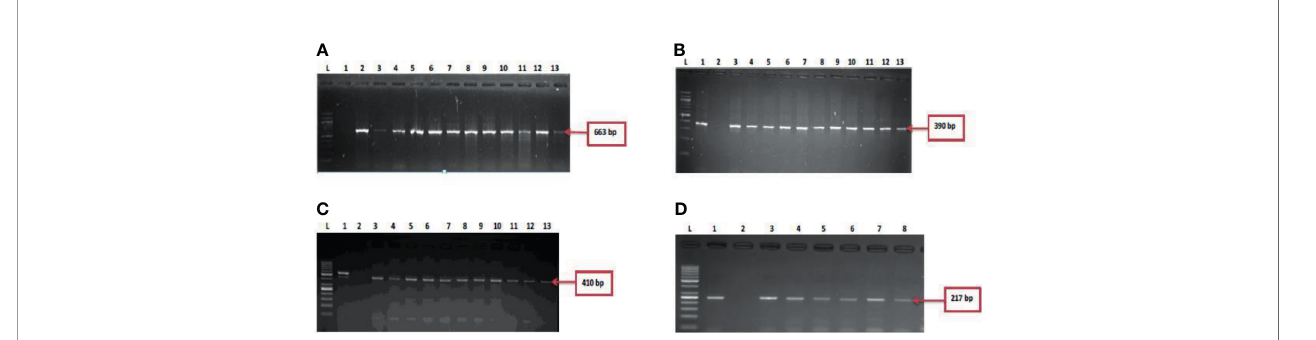
FIGURE 2 | (A) = gel electrophoresis showing the 16s rRNA gene among isolates belonging to the Vibrio genus. Lane L: Molecular DNA-marker (100 bp); Lane 1: Negative control (-ve); Lane 2-13: positive isolates of 16s rRNA gene (663 bp): (B) = Gel electrophoresis showing the vmh gene among isolates belonging to the V. mimicus . Lane L: Molecular DNA-Marker (100 bp), lane 1: positive control (DSM 19130), Lane 2: Negative control (-ve); Lane 3-13: positive isolates of vmh gene (663 bp); (C) = Gel electrophoresis showing the hsp60 gene among isolates belonging to the V. vulni fi cus. Lane L: Molecular DNA-marker (50 bp), lane 1: positive control (DSM 10143), Lane 2: Negative control (-ve); Lane 3-13: positive isolates of hsp60 gene (410 bp) and (D) = Figure 2D : Gel electrophoresis showing the ToxR gene among isolates belonging to the V. fl uvialis. Lane L: Molecular DNA-marker (50 bp), lane 1: positive control (DSM 19283), Lane 2: Negative control (-ve); Lane 3-8: positive isolates of ToxR gene (217 bp).